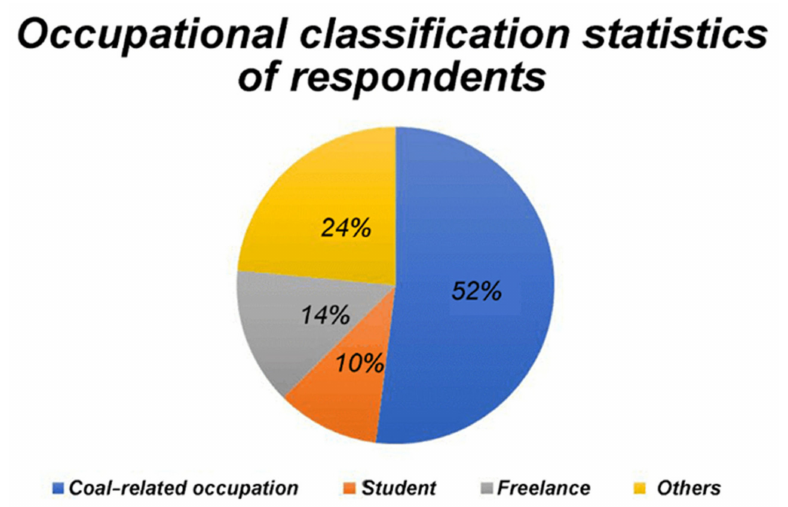
Figure 4. Respondents’ occupational